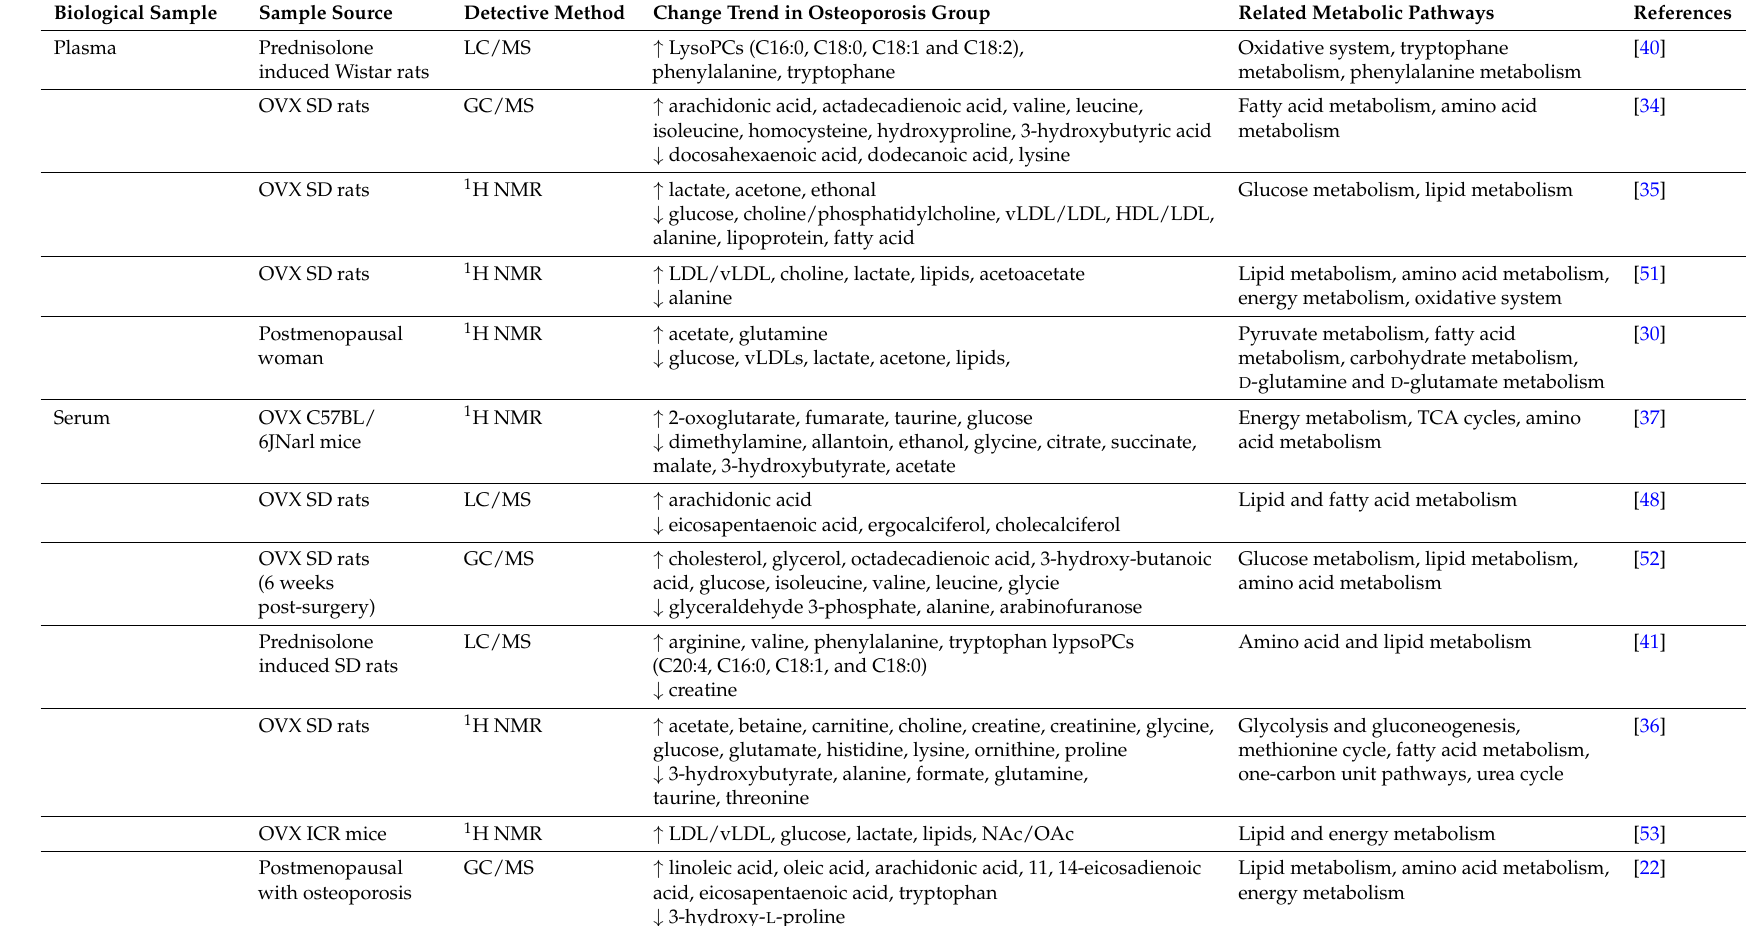
Table 2. The biomarkers and related metabolic pathways in osteoporosis by metabolomics